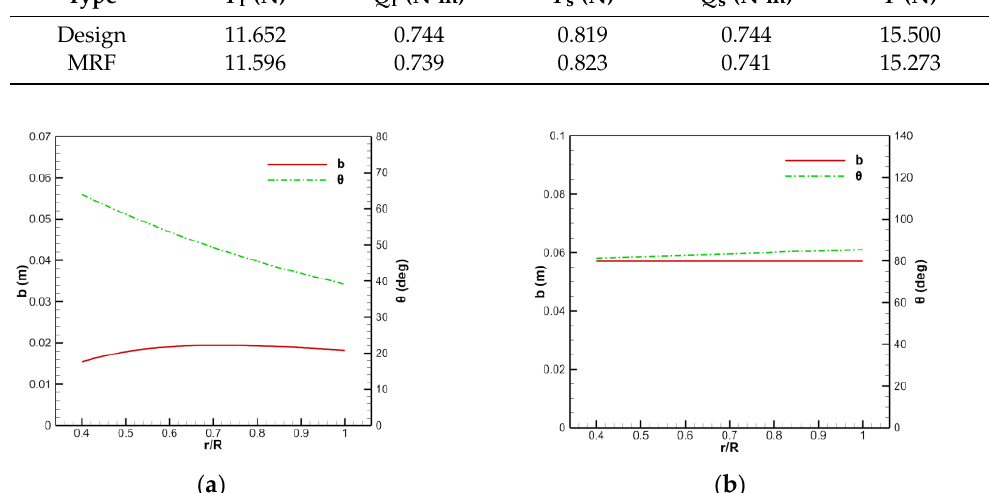
Figure 13. Design results of the chord length and torsion angle of the blade in the incoming flow